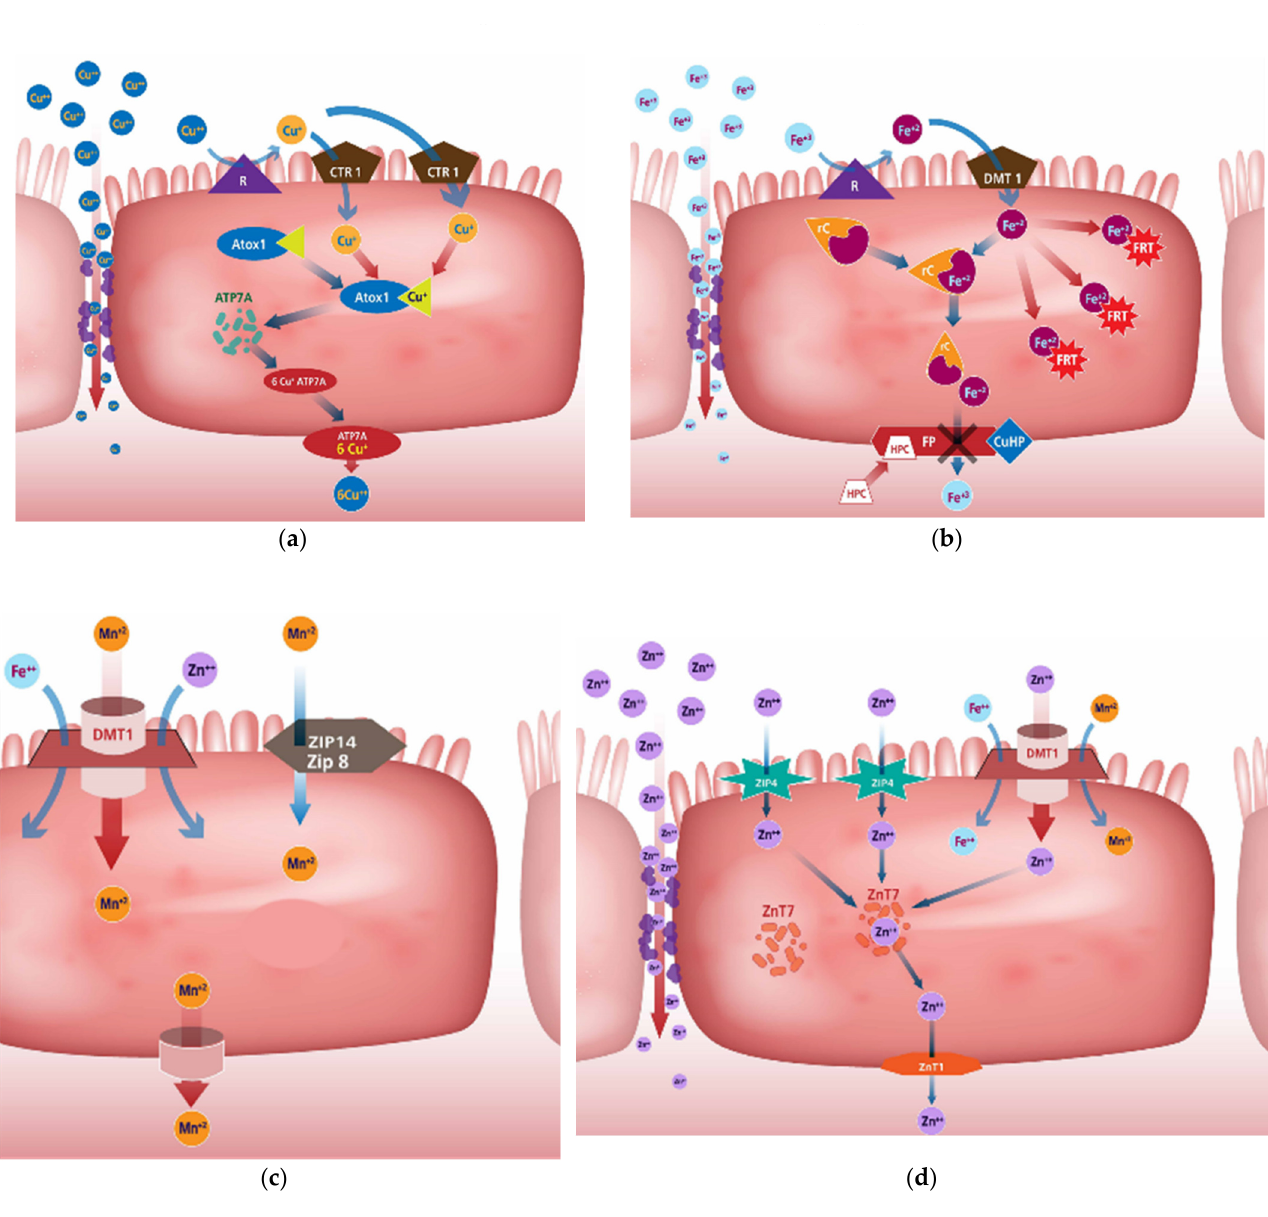
Figure 2. Cu ( a ), Fe ( b ), Mn ( c ) and Zn ( d ) trace mineral uptake mechanisms at adequate mineral status. Adapted from Goff [67].